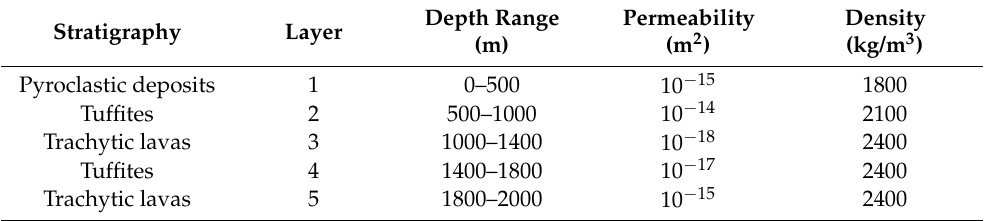
Table 4. Stratigraphy and thermo-physical properties of Campi